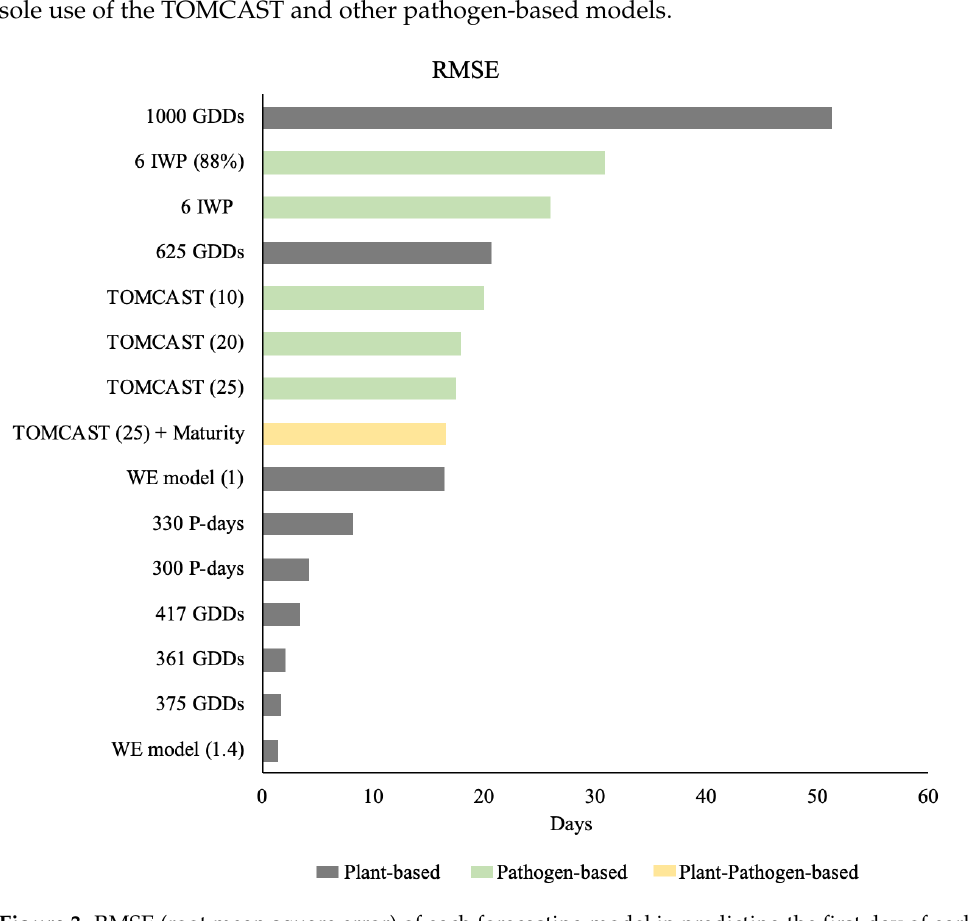
Figure 3. RMSE (root mean square error) of each forecasting model in predicting the first day of early blight symptoms.